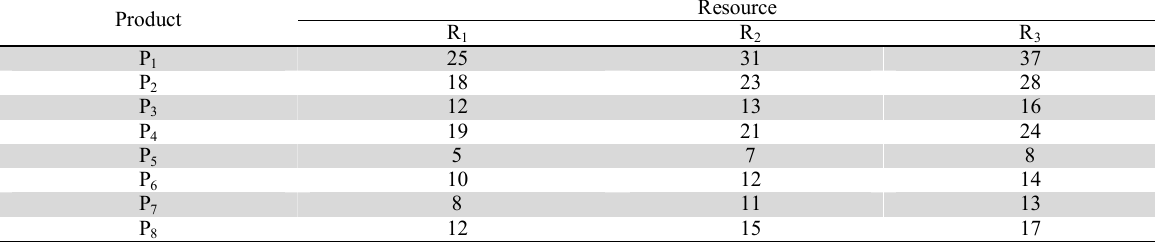
Machining time (minutes) of various product- resource